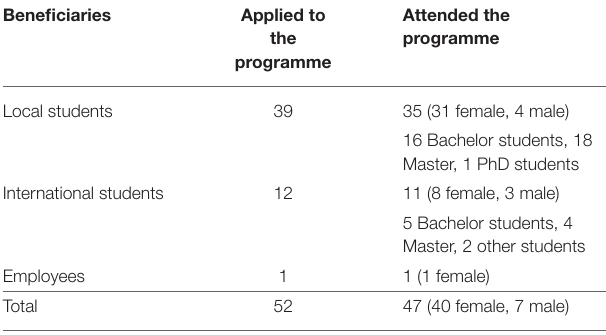
TABLE 2 | Participants of the COVID-19 counselling programme.